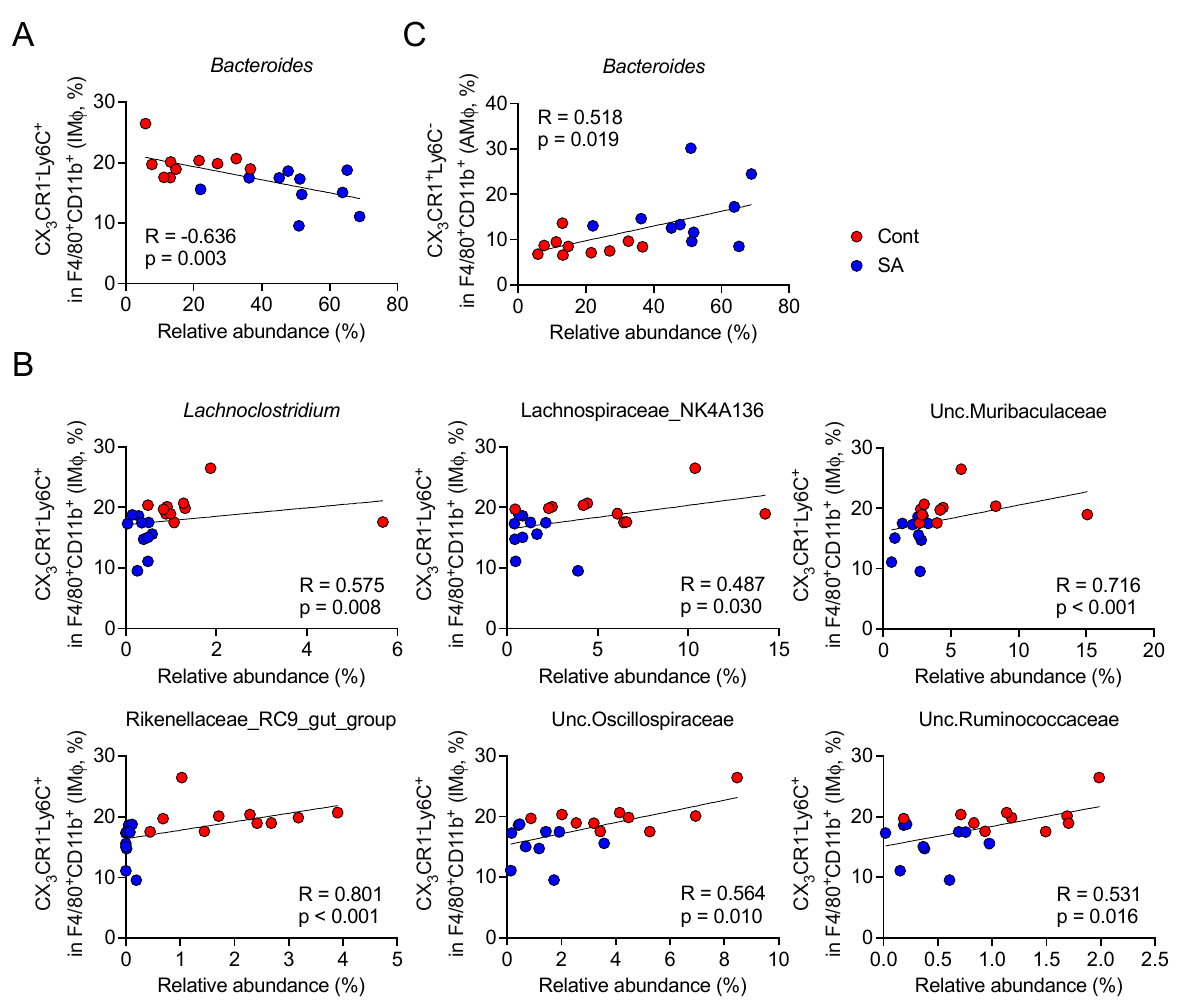
Figure 5. Bacteroides were negatively correlated with the abundance of inflammatory monocytes in the colon. Mice were fed a HFD supplemented with or without 5% sodium alginate (SA) for 4 weeks ( n = 10 mice per group). Spearman’s rank correlation coefficient was used to analyze the correlation between the relative abundance of gut microbiota and the percentage of colonic macrophages. ( A , B ) Scatter plots showing the ( A ) negative or ( B ) positive correlation between the gut microbiota and CD11b + F4/80 + CX 3 CR1 low Ly6C + cells in the colon. ( C ) Scatter plots showing the positive correlation between gut microbiota and CD11b + F4/80 + CX 3 CR1 high Ly6C − cells in the colon. Cont: HFD diet; SA: HFD diet with 5% sodium alginate; R: spearman correlation coefficient; p : p